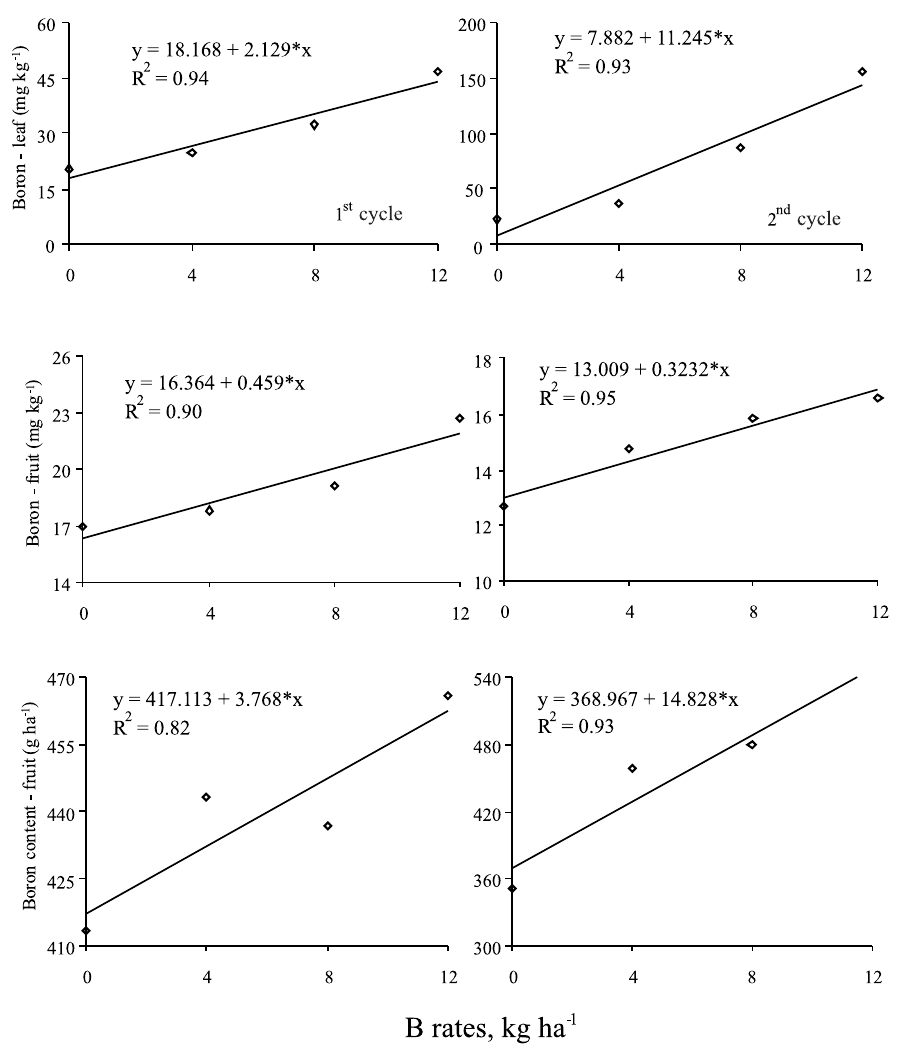
Fig. 2 – Equation of regression among the B rates with B concentration in leaves and fruits, and with B content in fruits of two yield cycles. Significant at 5% level of probability by